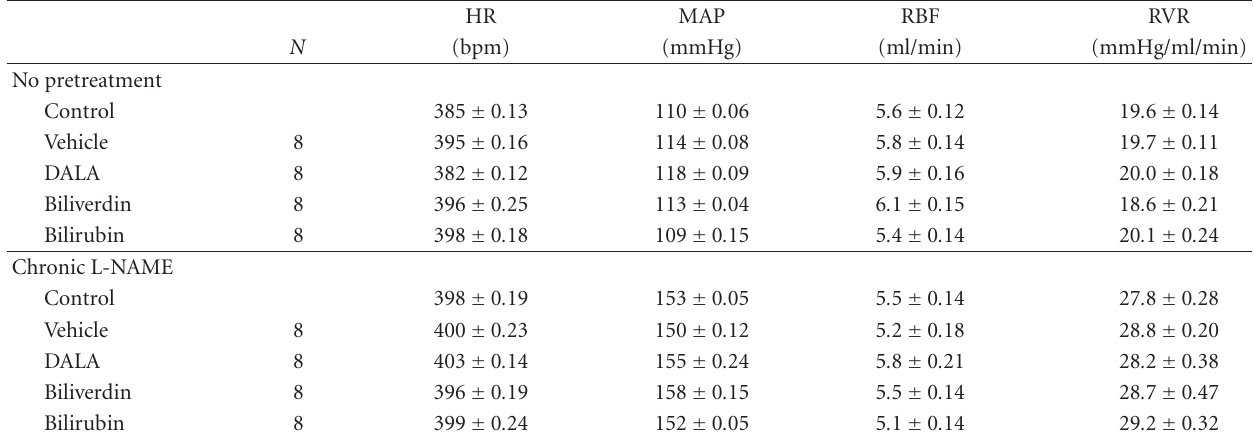
Table 1: E ff ects of DALA (80 μ mol/kg, IV), biliverdin (20mg/Kg, IV), and bilirubin (30mg/Kg, IV) administration on heart rate (HR), mean arterial pressure (MAP), renal blood flow (RBF), and calculated renal vascular resistance